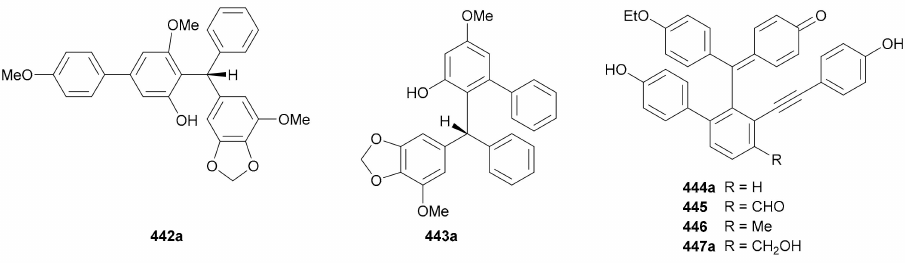
Figure 26. Structures of triarylmethanes.